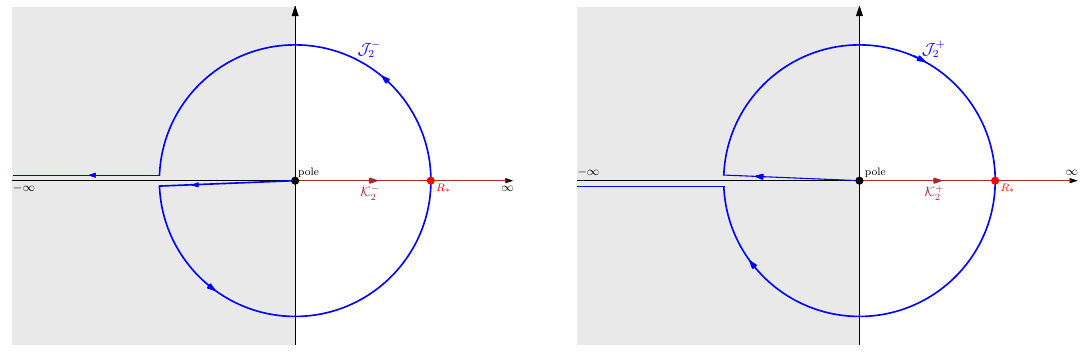
are the two types of steepest descent cycles. J − 2